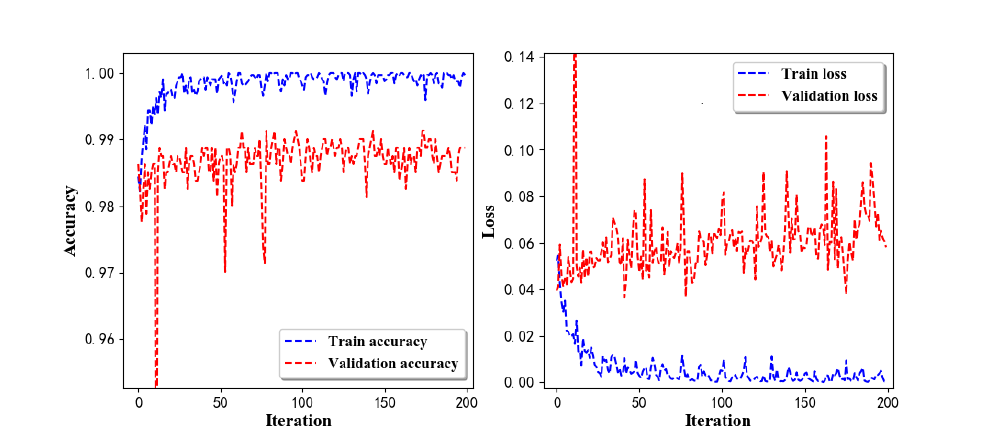
Figure 20. Accuracy ( left ) and loss ( right ) information of training and validation